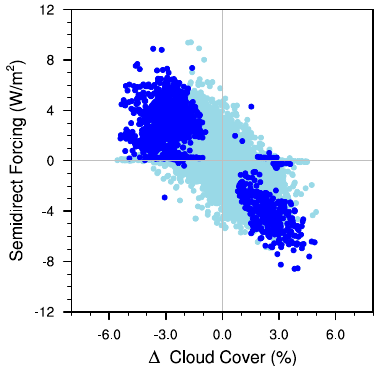
Figure 5. Scatterplot of model results of annual averaged BC TOA SDE in relation to cloud cover changes for the differences of the simulations BASE and noBC. Results from model grid cells that are statistically significant at 95% levels are plotted in dark blue, results from grid cells with results with statistical significance below 95% are plotted in light blue.